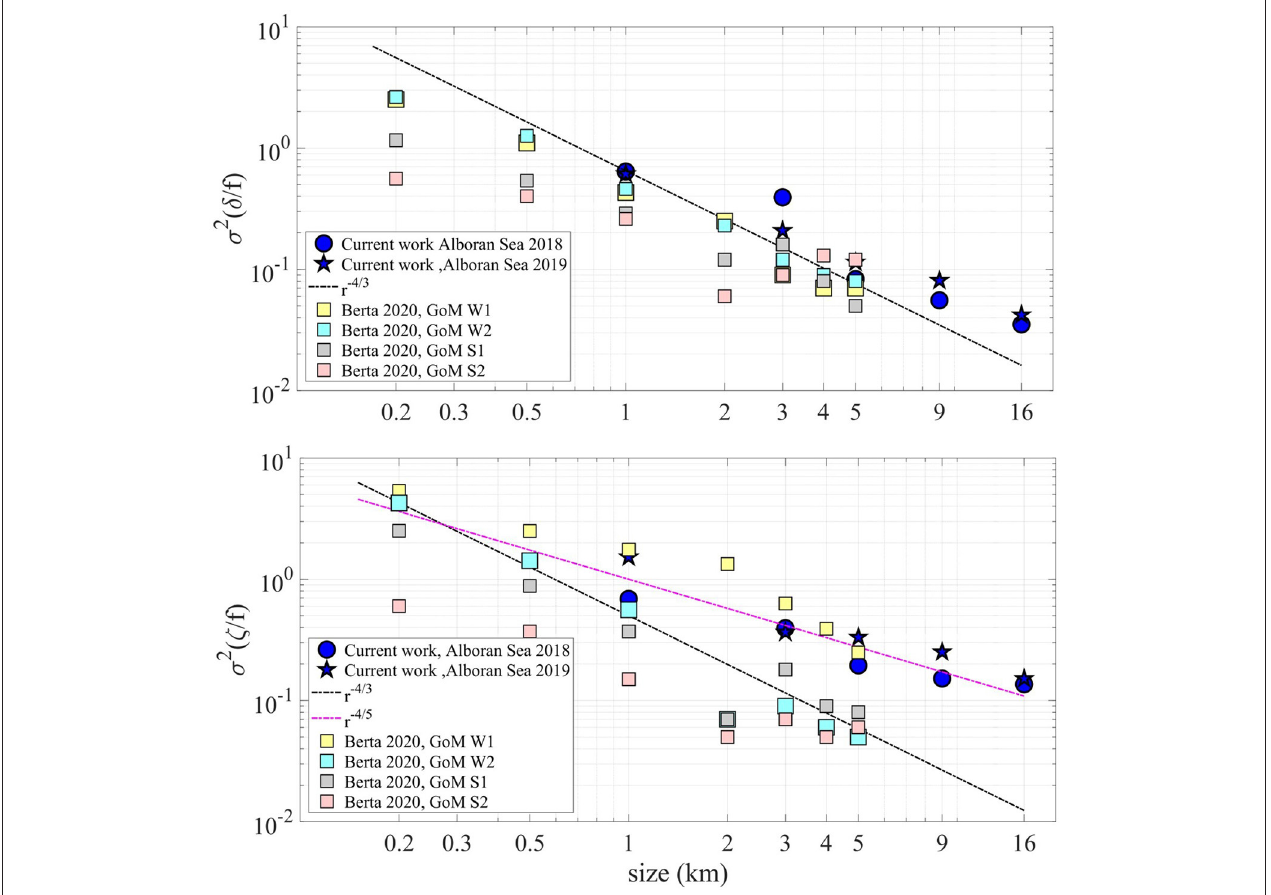
FIGURE 12 | Scale dependence of the variance of divergence (upper) and vorticity (lower) for surface values from Berta et al. (2020b) in the Gulf of Mexico (GoM) and from present results. For comparison, the scaling laws for velocity derivatives are also shown: black line for